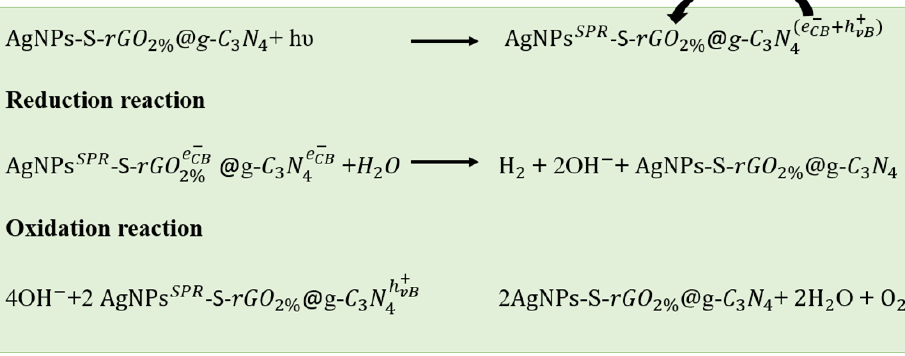
Figure 12. Proposed enhanced hydrogen production mechanism of AgNPs-S-rGO 2% @ g -C 3 N 4 .